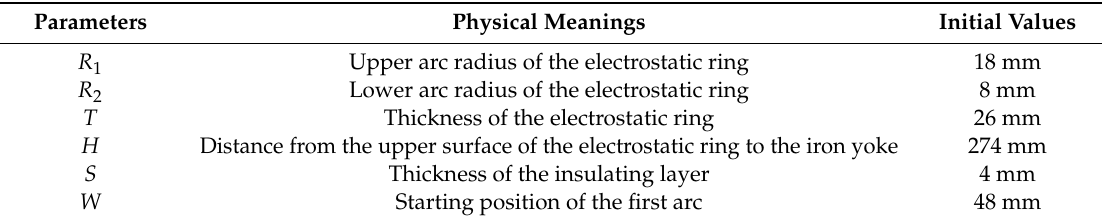
Figure 1. Calculation model of 500kV power transformer insulation structure. (a) Integral structure; and (b) partial structure. Table 1. Initial parameter values.